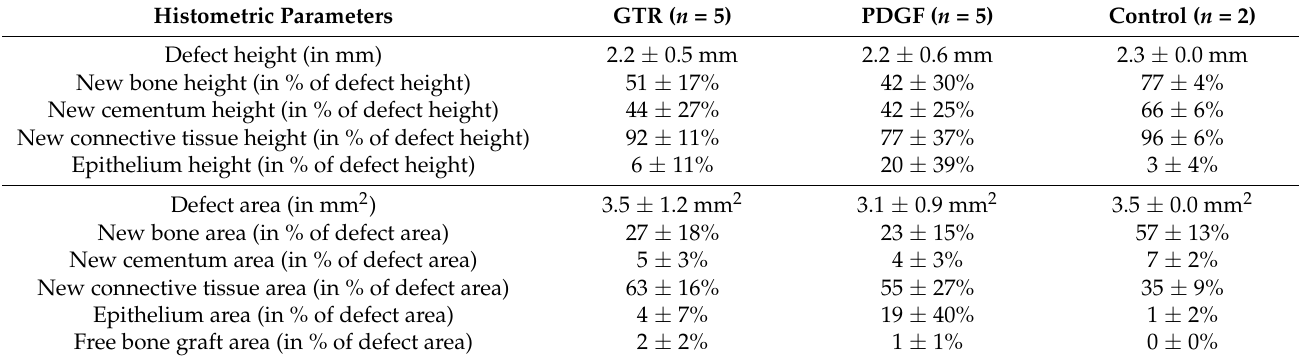
Table 1. Histometric results in small keyhole class III furcation defects.